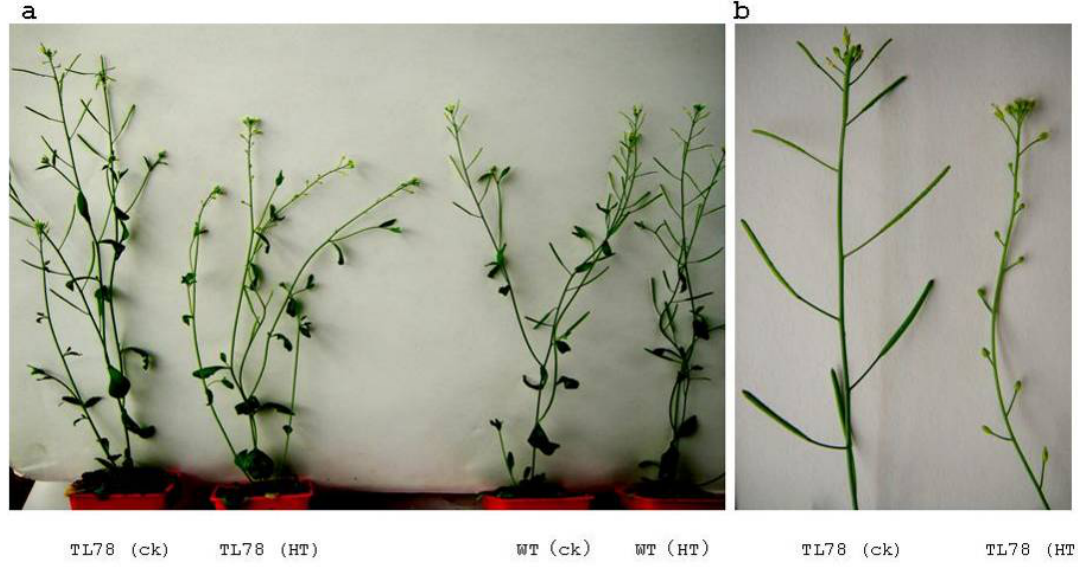
Figure 6. FBA in transgenic Arabidopsis under heat stress. ( a ) The image of homozygous transgenic Arabidopsis line and wild-type plant on the eighth day after heat stress; ( b ) Local amplification of ( a ). TL78(ck), transgenic plants at normal temperature; TL78(HT), transgenic plant on the eighth day after treated with 32 ± 0.5 °C for 36 h; WT(ck), Col-0 of Arabidopsis thaliana at normal temperature; WT(HT), Col-0 of Arabidopsis thaliana on the eighth day after treated with 32 ± 0.5 °C for 36 h.